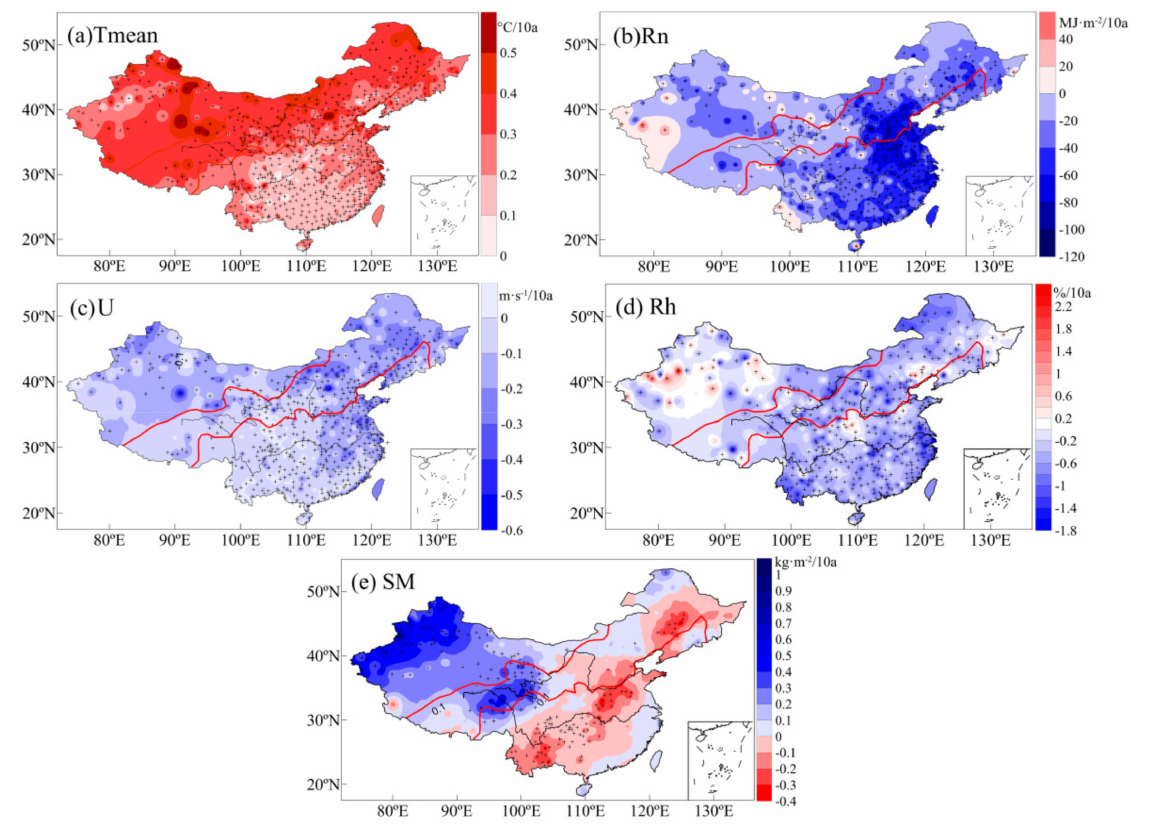
Figure 11. Trends of each environmental factor from 1960 to 2017, ( a ) Tmean, ( b ) Rn, ( c ) U, ( d ) Rh, ( e ) SM, +indicates that the trend was significant at the 0.05